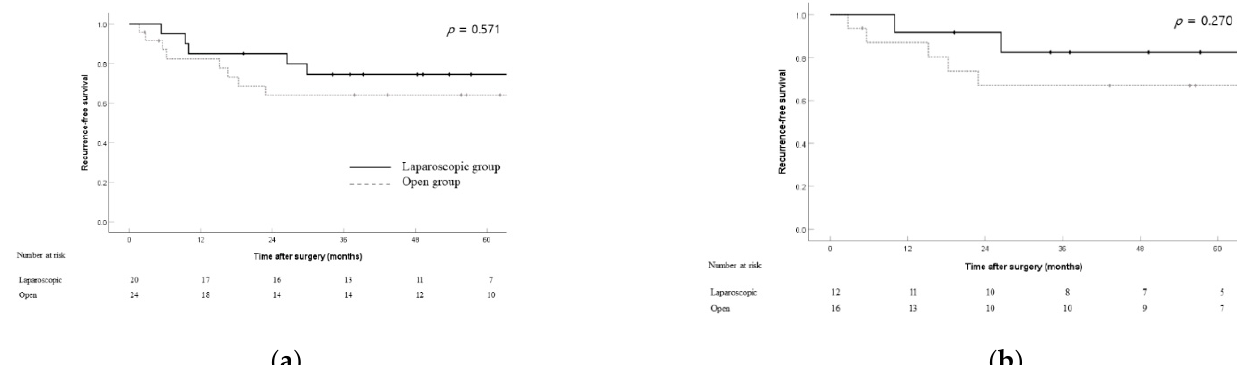
Figure 2. Tumor-specific overall survival between the laparoscopic and open groups in the overall cohort ( n = 44) ( a ), T2 patients ( n = 28) ( b ), and N0 patients ( n = 31) ( c ). The RFS rates for both groups in the overall cohort (3 year RFS rate: 74.4% vs. 64.0%; p = 0.571), patients with stage T2 tumors (3 year RFS rate: 82.5% vs. 67.0%; p = 0.27), and patients with stage N0 tumors (3 year RFS rate: 92.3% vs. 75.3%; p = 0.39) showed no significant differences (Figure 3).